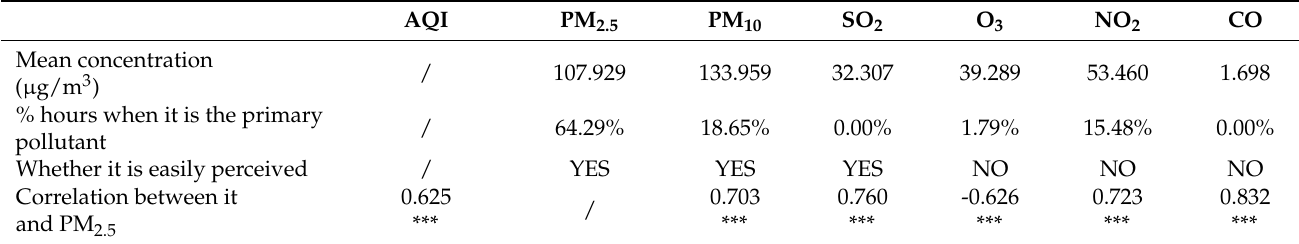
Table A3. Air pollution Statistics Based on Beijing data.